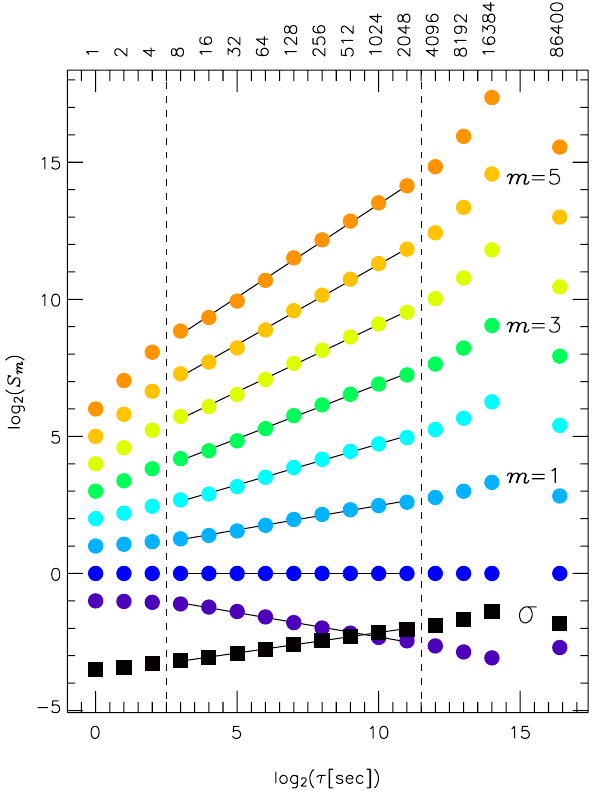
Fig. 6. A generalised structure function (GSF) analysis of all the velocity fluctuations δ v los observed on Tasmania beam 4 (Table 1). The results show the variation of the moments S m ( τ) = h| δ v sw ( t, τ ) | m i with temporal scale τ for orders m =− 1 to 6. The results are quasi-linear on a log-log plot between τ ∼ 8s and ∼ 2048s (34min). The variation of the standard deviation σ ( τ) =[ S 2 ( τ) ] 1 / 2 with τ (squares) is also shown. Error bars were drawn at the 3 σ level but are negligible. Weighted least squares fits have been applied to all the